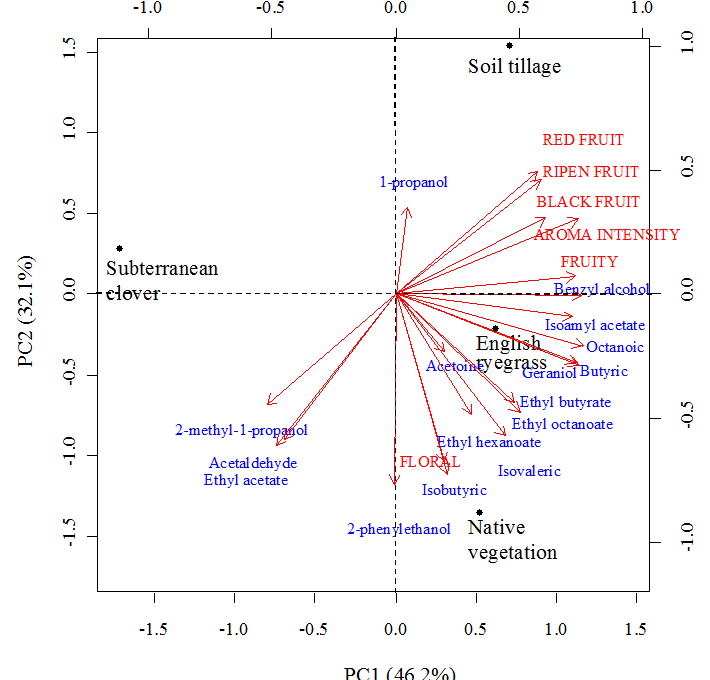
Figure 5. Principal component analysis (PCA) of Mencía wines: Biplot for the first two components (PC) for volatile compounds with odor activity values greater than one (lower-case letters) and the sensory descriptors related to wine aroma (capital letters).